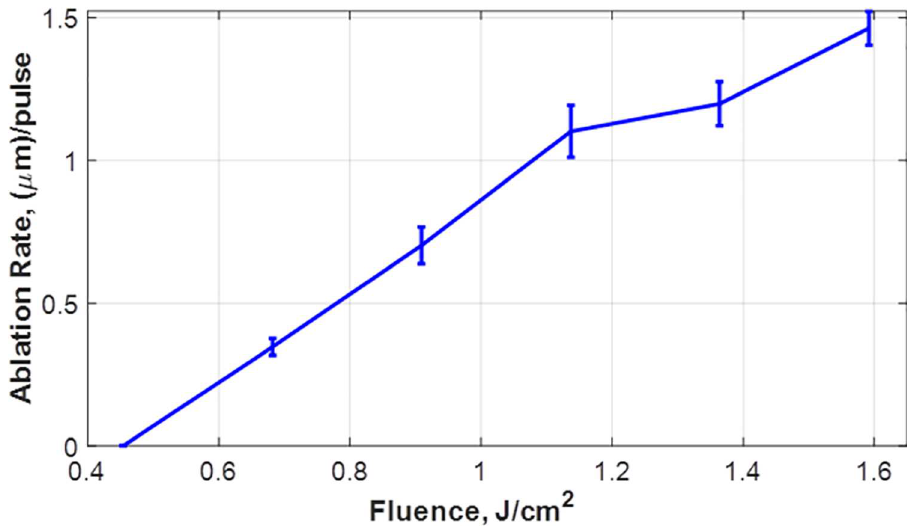
Fig 5. Ablation rate in PMMA at different fluence values.